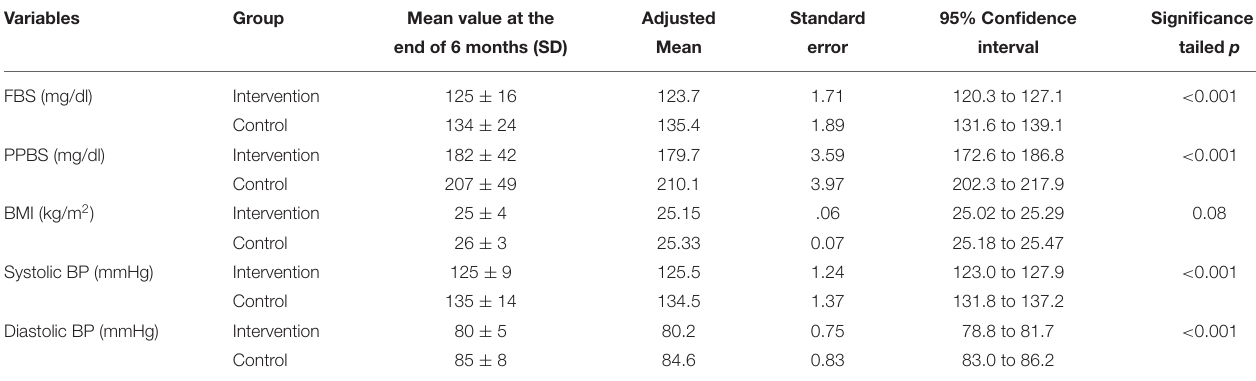
TABLE 3 | Change in clinical parameters adjusted for baseline values.